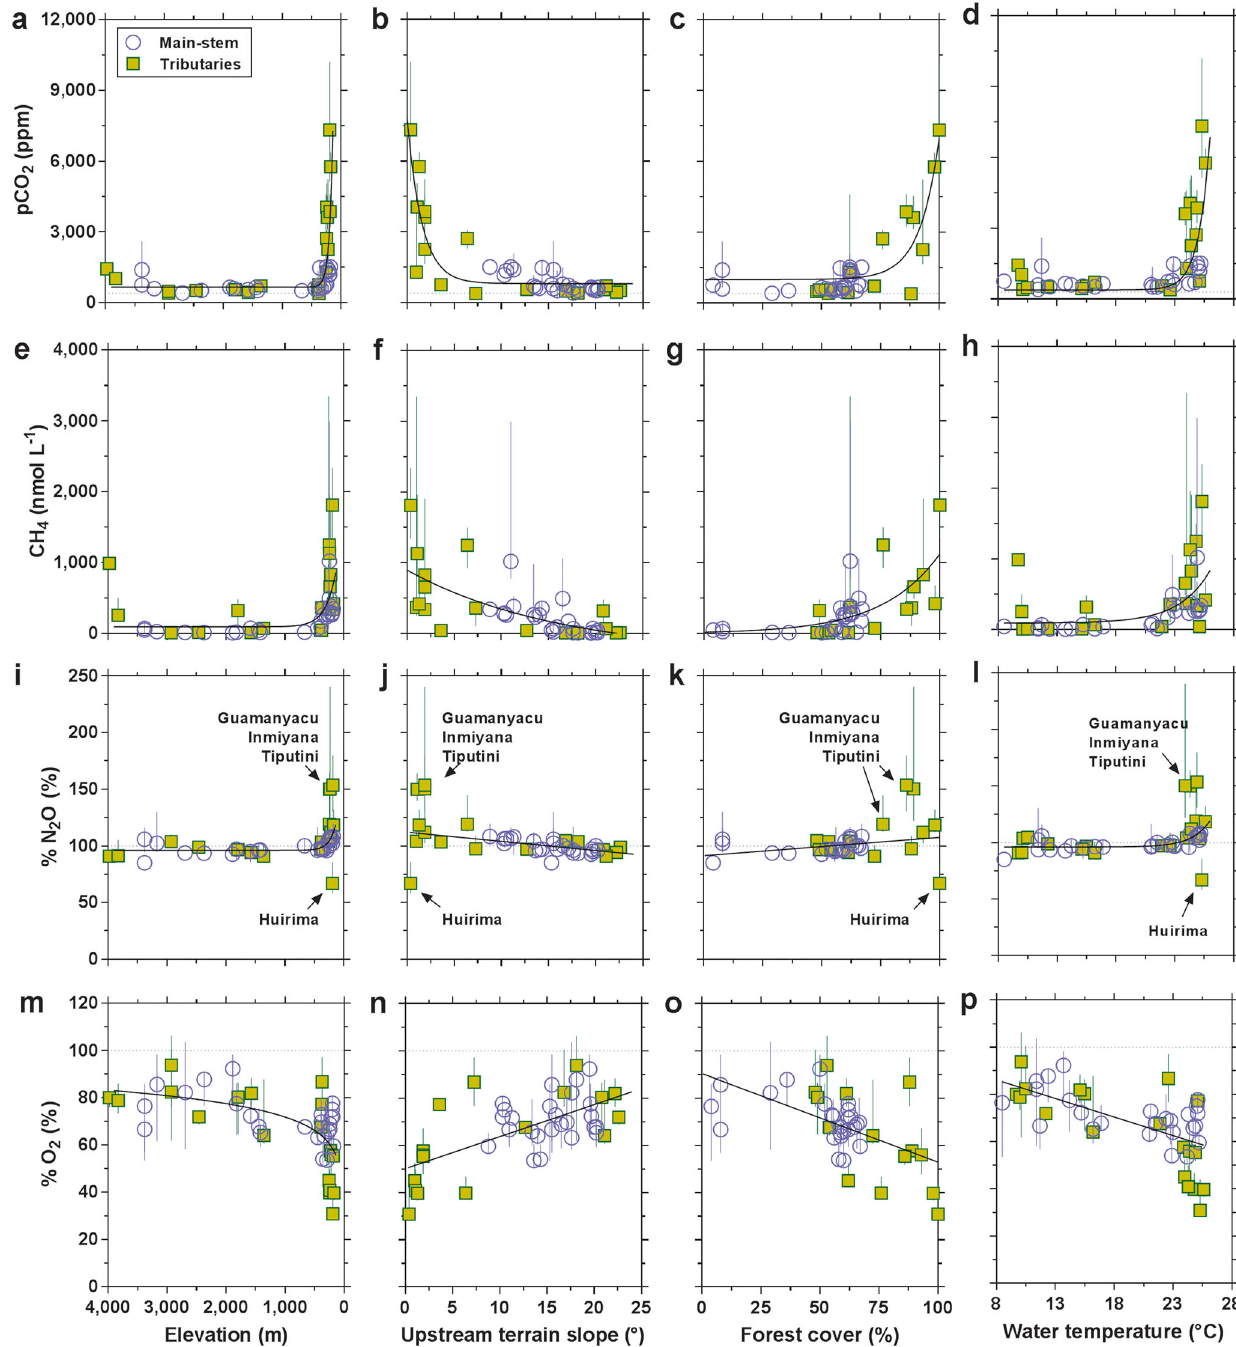
Fig. 2 Strong elevation gradients of pCO 2 , CH 4 and %N 2 O in the Andean headwater and piedmont streams. Variations of the partial pressure of CO 2 (pCO 2 ), CH 4 dissolved concentration, N 2 O saturation level (%N 2 O), and oxygen saturation level (%O 2 ) in the Napo streams as a function of elevation ( a , e , i , m ), catchment slope ( b , f , j , n ), forest cover ( c , g , k , o ), and water temperature ( d , h , l , p ). Symbols show the median and error bars the interquartile range, stations in the main-stem are shown by blue circles and in the tributaries by green squares, and black lines indicate linear or exponential fi ts to the data. Solid lines show fi ts to the data (Supplementary Table